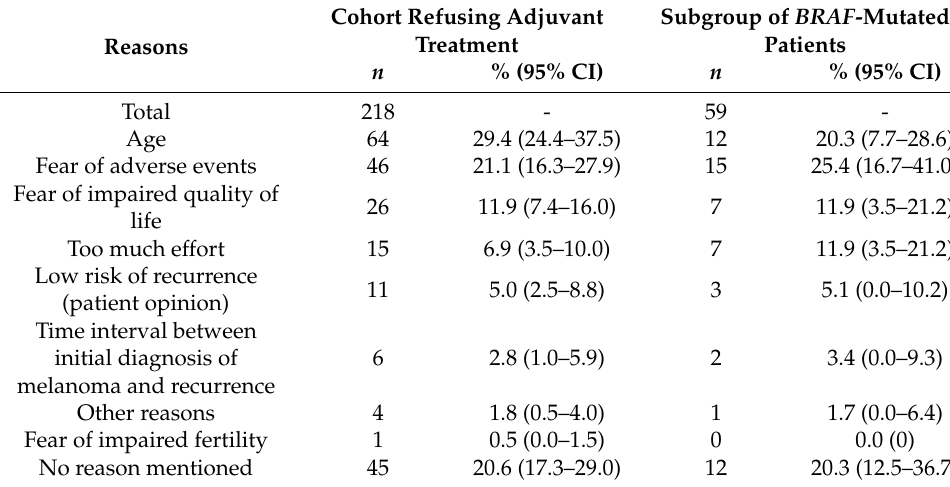
Table 2. Patients ´ reasons to decline systemic adjuvant